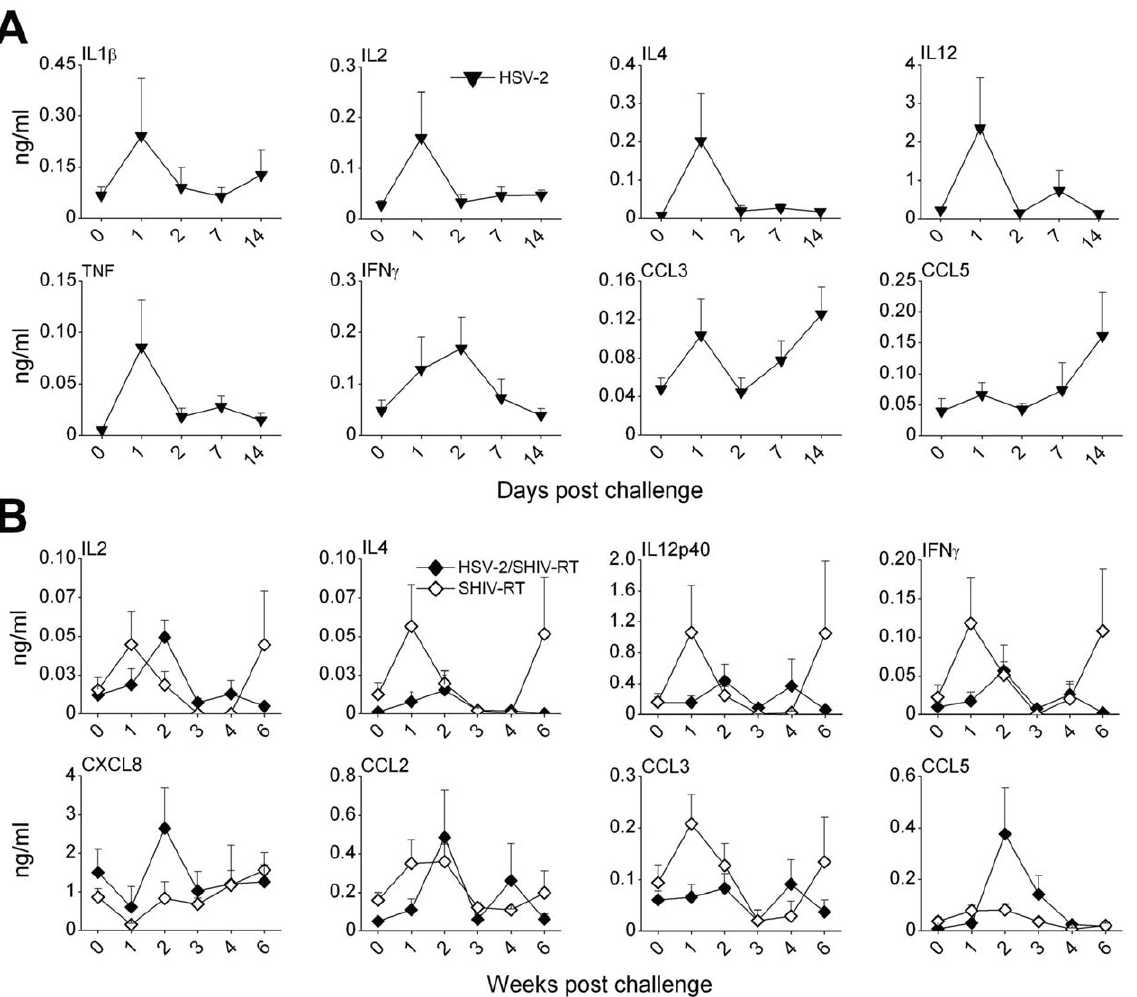
Figure 3. Local immune responses following HSV-2 infection. (A) Naı¨ve Depo-Provera-treated monkeys (n=12) were challenged i.vag. with 2 6 10 8 pfu HSV-2. Cytokine/chemokine levels were measured in the vaginal swabs during the first days after challenge using the 14-plex Luminex assay. The mean concentration ng/ml ( 6 SEM) of each factor is shown. (B) Vaginal swabs were collected after HSV-2/SHIV-RT co-challenge of HSV-2- infected animals (n=5, closed symbols) or SHIV-RT challenge of naı¨ve animals (n=6, open symbols). The cytokine/chemokine levels (mean 6 SEM ng/ ml) were measured by Luminex assay on a weekly basis.